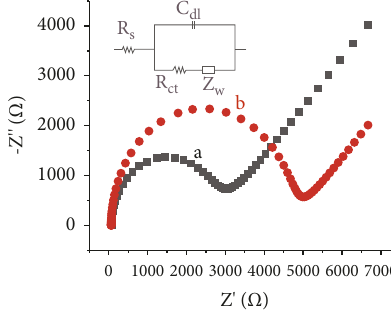
Figure 6: Electrochemical impendence spectroscopy plots of the unmodified CPE (a) and HDPBA ‒ CPE (b) in 5mM K 3 [Fe(CN) 6 ]/ KCl (0.1M) solution.